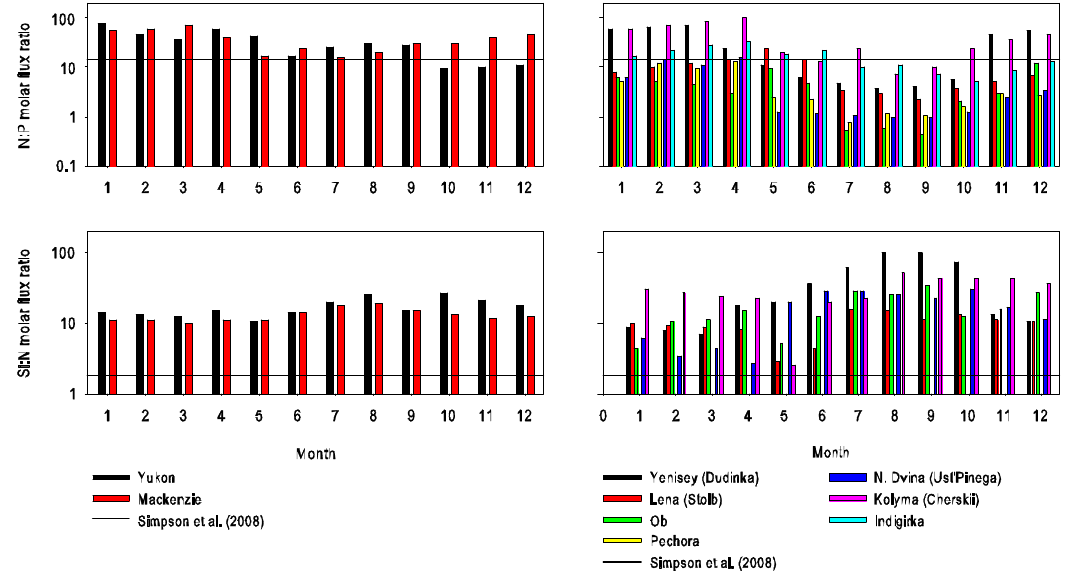
Fig. 6. N:P (top panels) and Si:N (bottom panels) molar flux ratios computed from monthly flux estimates for the North American and Eurasian rivers. Table 3. Annual primary production (total (PP) and new (PP new )), riverine nitrate flux, and contribution of riverine nitrate to new primary production for the high Arctic Ocean and its river-influenced shelf seas. In the last three columns, the average (between brackets) is given along with the average ± standard